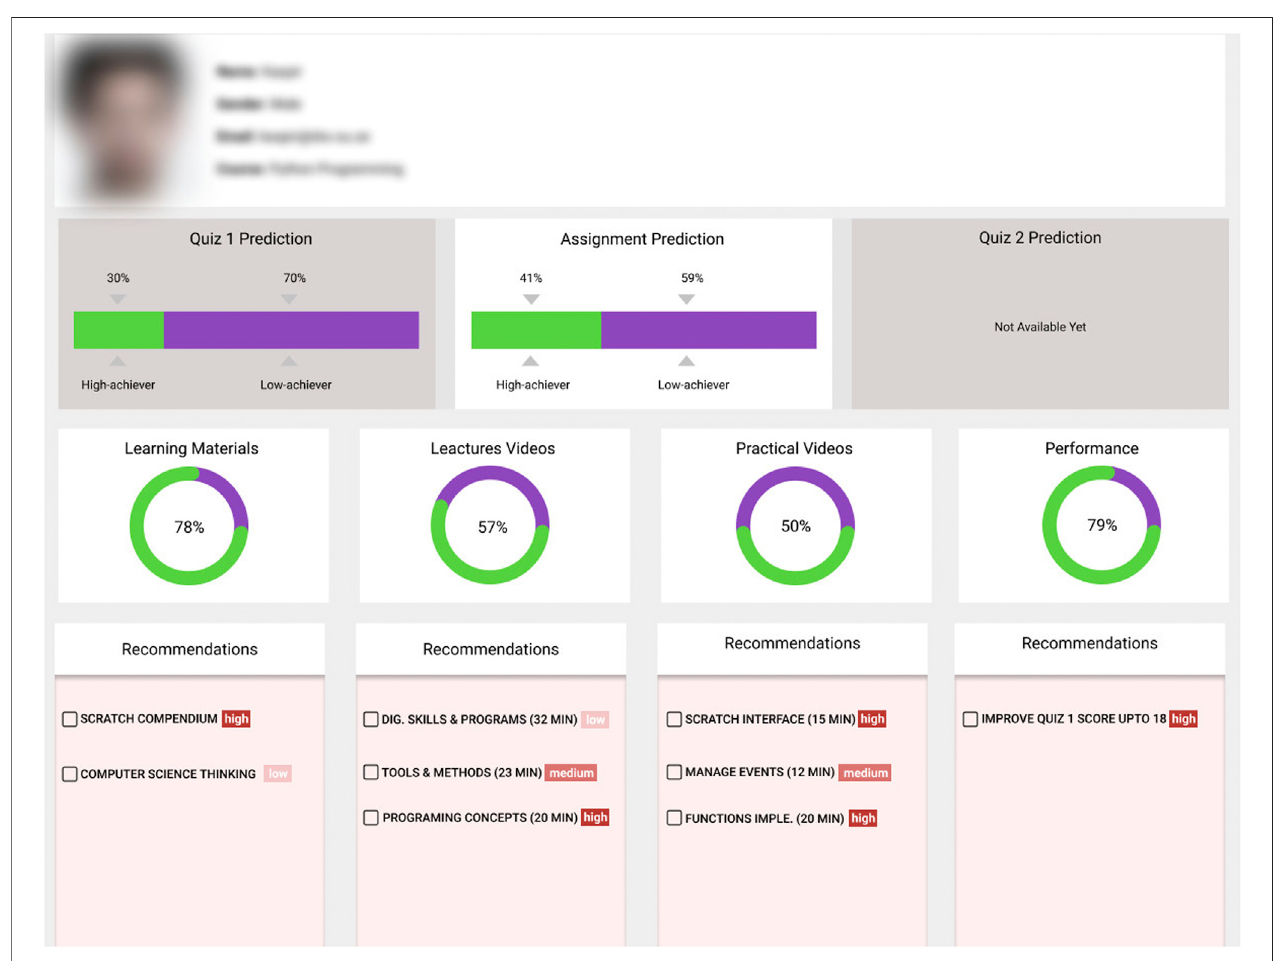
FIGURE 8 | Student